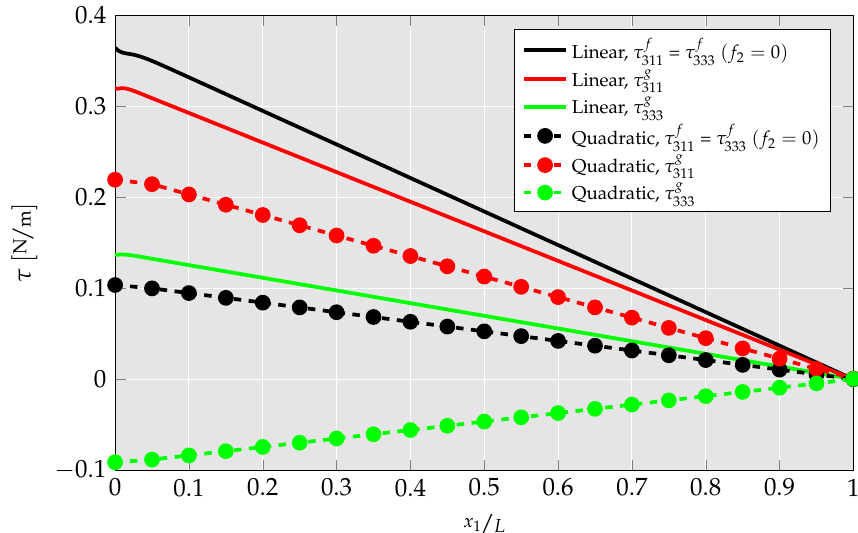
Figure 21. Flexoelectric and mechanical strain gradient contributions to the higher-order stress components τ 311 and τ 333 for linear and quadratic element along the length of the beam for prescribed mechanical displacement.